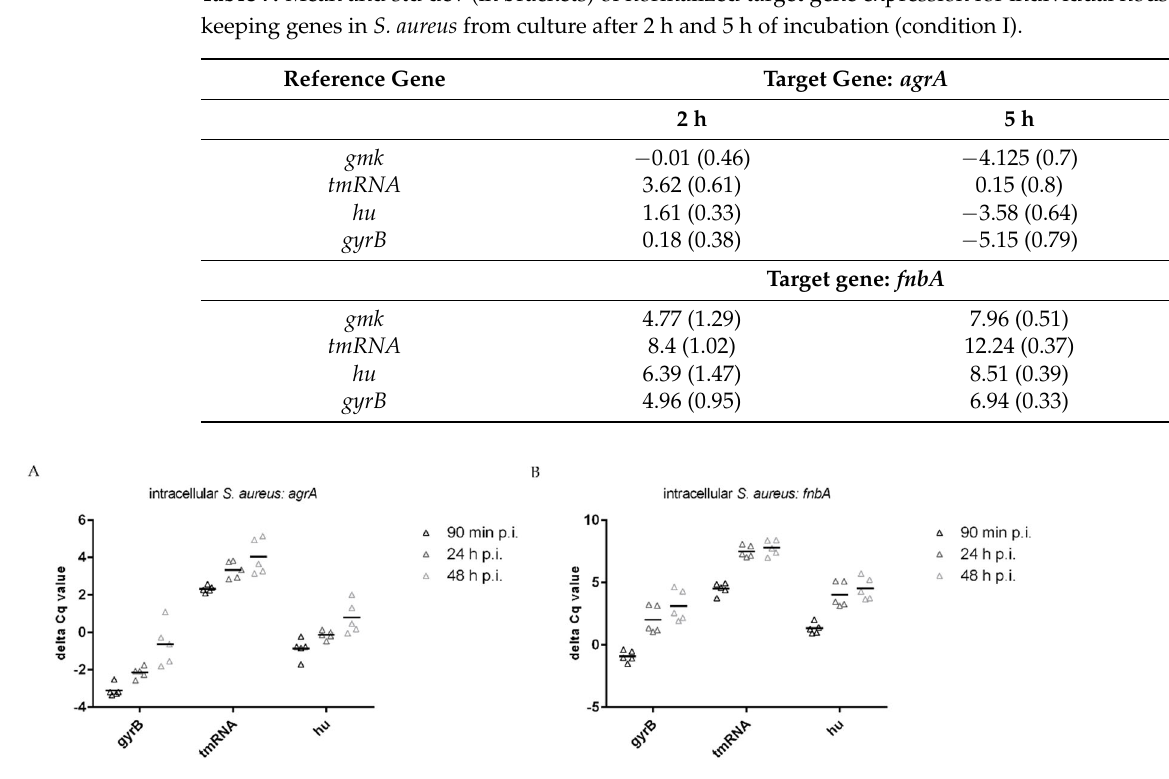
Figure 6. Variability of delta C q values of intracellular S. aureus at 90 min, 24 h, and 48 h postinfection (condition II) for each reference gene individually for ( A ) agrA and ( B ) fnbA . Bars indicate the mean